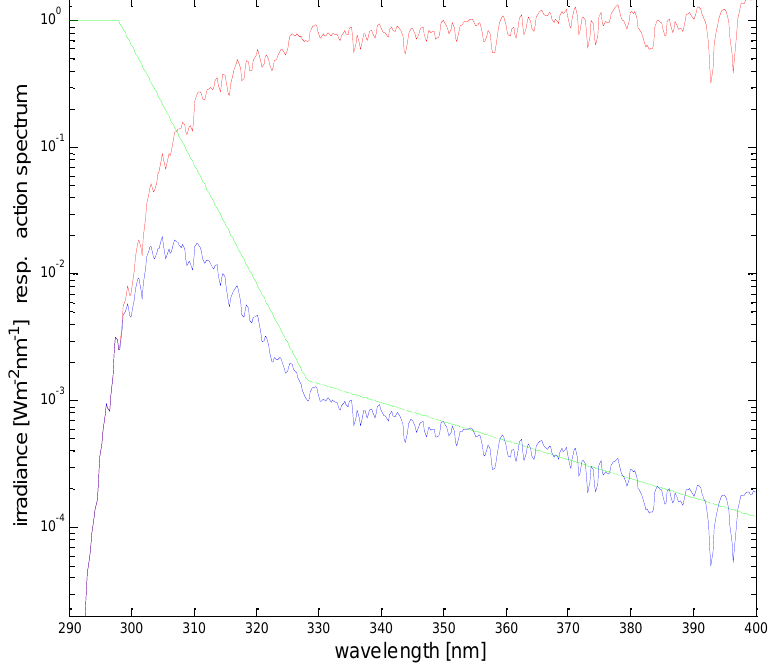
Figure 1. Erythema action spectrum ( green ), typical solar spectrum ( red ), and erythemally weighted solar spectrum ( blue ). The erythemally weighted irradiance is the integral under the blue curve. The classification and color coding of the UVI by the World Health Organization [4] is: 1, 2: low, green; 3, 4, 5: moderate, yellow; 6, 7: high, orange; 8, 9, 10: very high, red; 11+: extreme, violet. Only